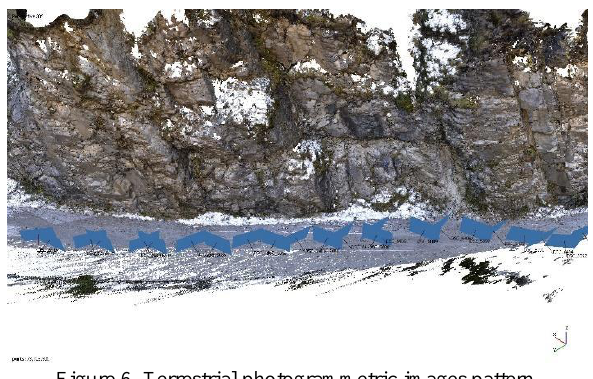
Figure 6. Terrestrial photogrammetric images pattern .